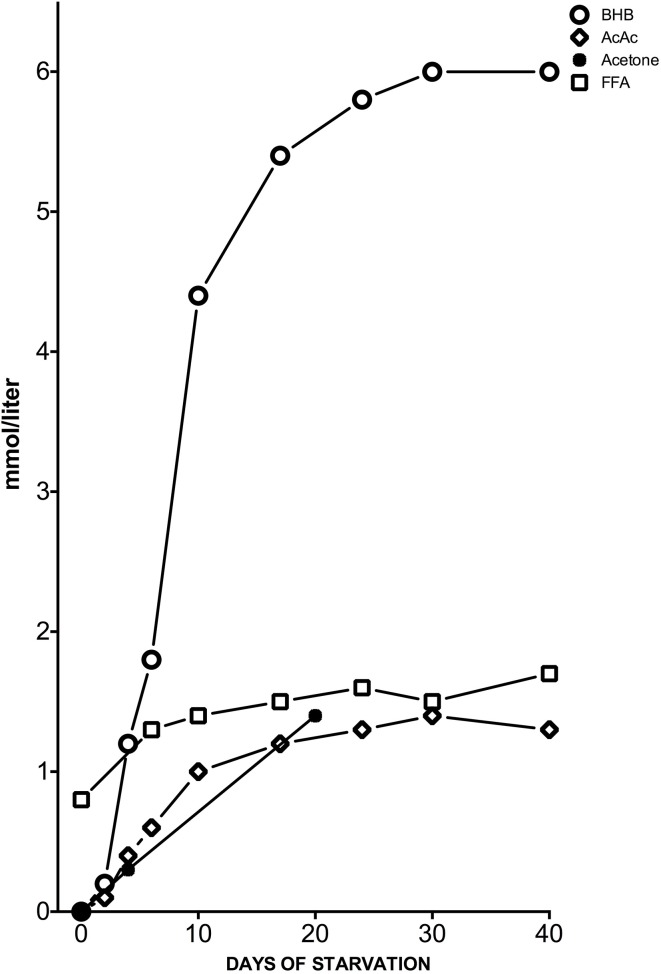
Concentrations of KB: acetone, BHB and acetoacetic acid (AcAc), and plasma free FAs (FFA) from the post-absorptive state to 40 days of starvation in human subjects. Y axis was expanded to better describe the great change in BHB concentration. Modified from Fukao et al. (2004), Owen (2005).